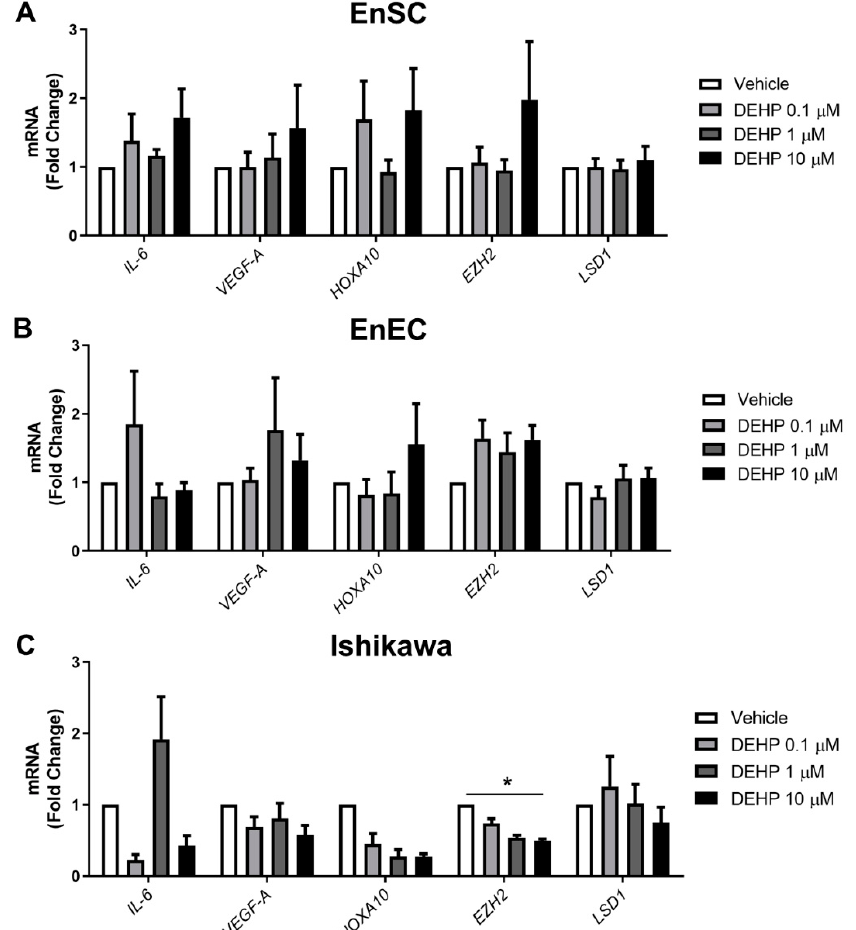
Figure 2. Endometriosis marker expression after acute DEHP exposure. After acute DEHP exposure in primary EnSC ( A ), primary EnEC ( B ), and Ishikawa cells ( C ); qPCR was performed for the endometriosis markers IL-6, VEGF-A, HOXA-10, EZH2, and LSD1. The results are represented as the mean ± SD of the data from six different samples in the case of the primary cells and three independent experiments in the case of the Ishikawa cells (* p < 0.05).